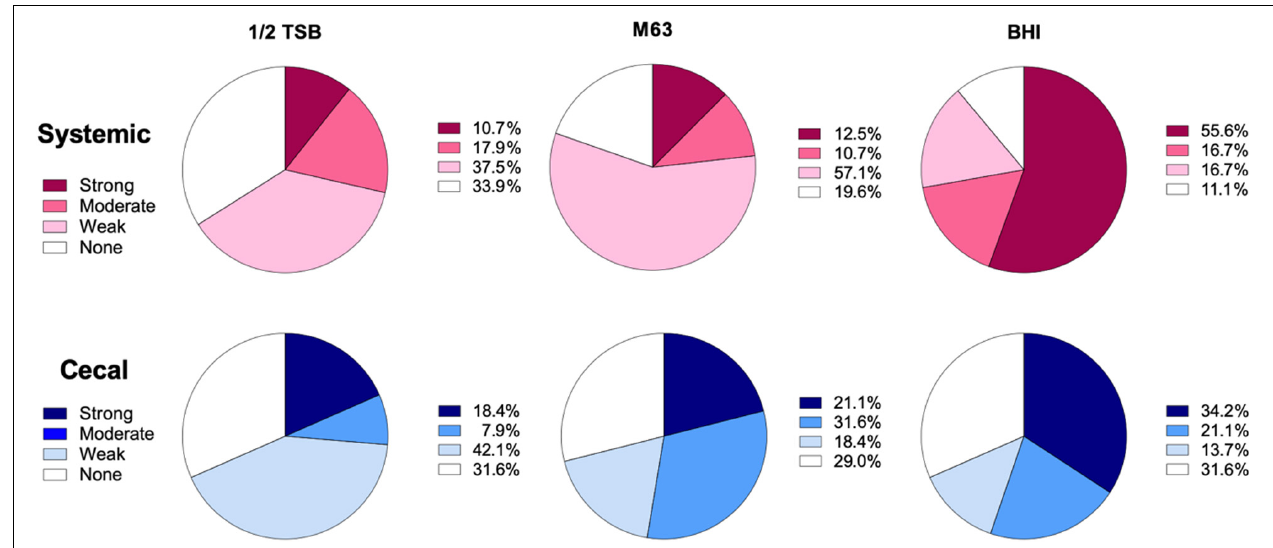
FIGURE 2 | Classification of biofilm formation by systemic and cecal E. coli isolates grown in three different growth media. Biofilm formation in 1 / 2 TSB, M63, and BHI broth was classified using a formula where the cut-off OD (OD c ) was set as three standard deviations above the average OD of the negative control wells: Strong = mean OD > 4*OD c ; Moderate = 4*OD c > mean OD > 2* OD c ; Weak = 2* OD c > mean OD > OD c ; or None = OD c > mean OD. Systemic isolates ( n = 56) are represented by shades of red/pink while cecal isolates ( n = 38) are represented by shades of blue.